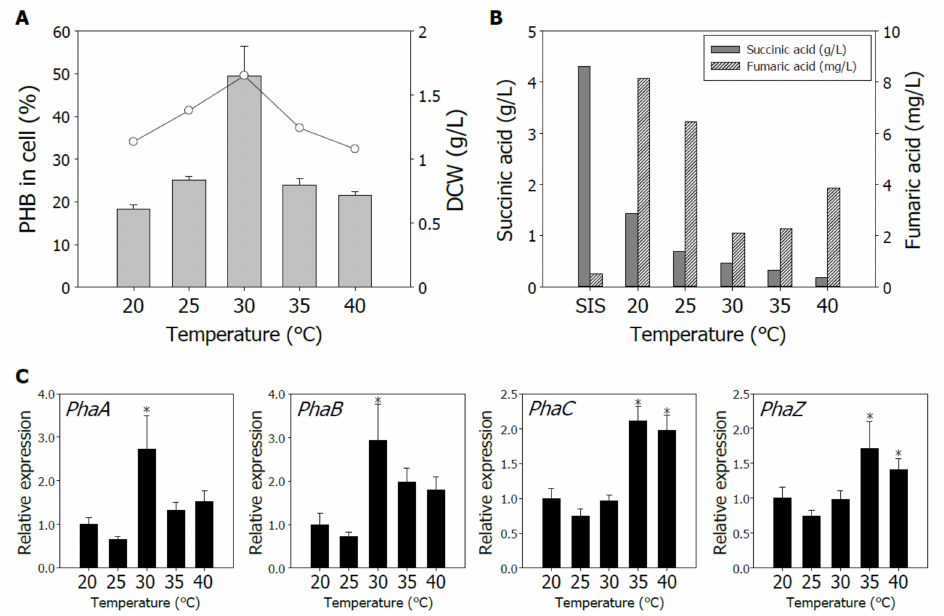
Figure 3. E ff ects of temperature on PHB production in R. sphaeroides . ( A ) PHB accumulation (% of dry cell weight) and cell growth at di ff erent temperatures. The cells were grown under dark-aerobic conditions and harvested at 48 h after inoculation. Gray bars for PHB contents and open circle lines for DCW. ( B ) Measurement of organic acids concentrations. ( C ) Expression of genes encoding PHB biosynthetic enzymes. Experiments were performed in triplicate and bars indicate standard error of the mean. Asterisks represent statistically significant di ff erence, as determined by a Student t -test (* p <